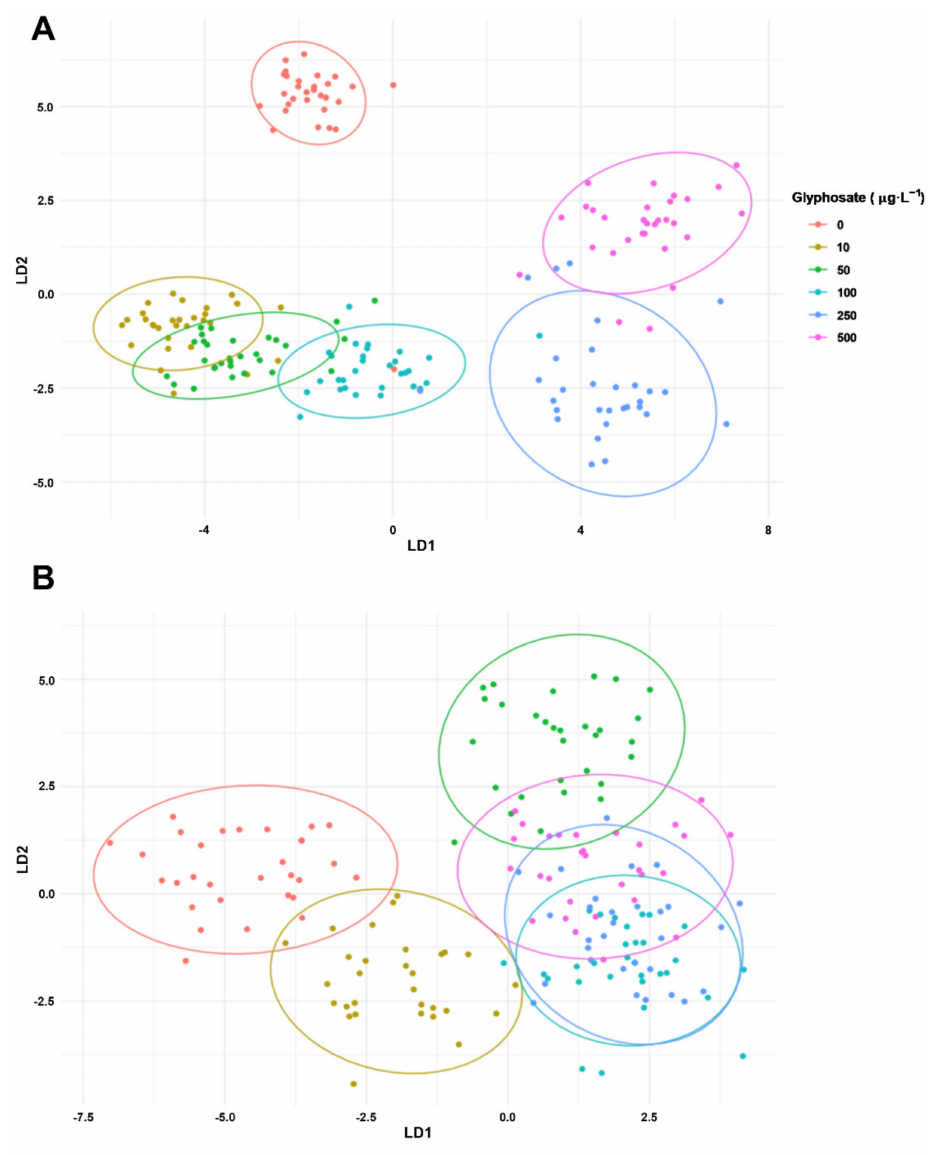
Figure 10. Linear discriminant analysis (LDA) using the ( A ) OJIP dataset and ( B ) the laser-induced fluorescence (LIF) dataset of Ulva lactuca following a 48-h glyphosate-based herbicide formulation in different concentrations. Ellipses group samples with lower statistical distance based on Euclidean